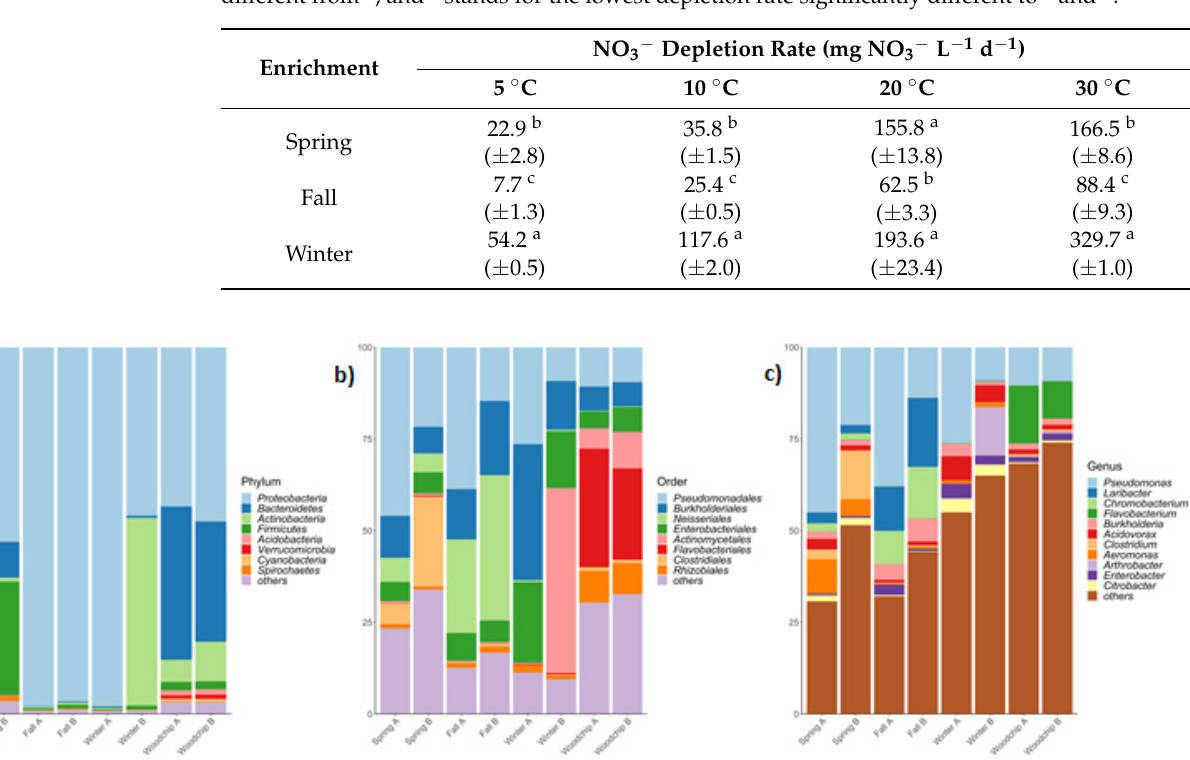
Figure A1. Relative microbial abundance in different samples: spring, fall and winter enrichments cultures and woodchips. Data are shown at ( a ) phylum level, ( b ) order level of the phylum Proteobacteria , and ( c ) genus level of the phylum Proteobacteria .